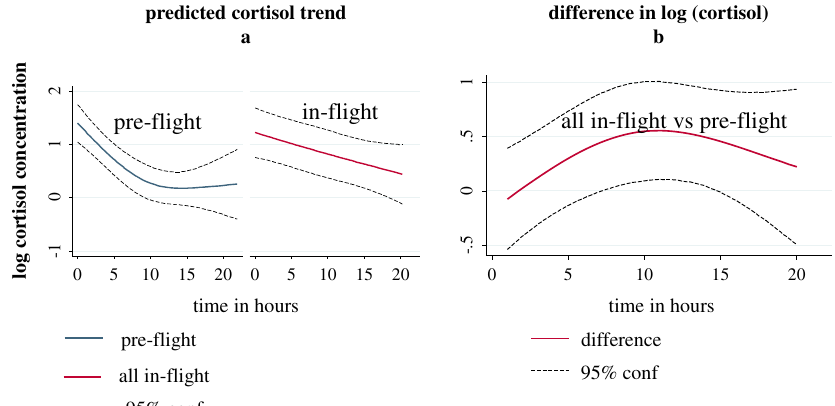
Fig. 5 Predicted mean log cortisol concentration trend and 95% con fi dence intervals for before- fl ight and during- fl ight phases in ( a ). b shows the difference between the two phases as well as the 95% con fi dence interval. It can be seen that the greatest difference occurs at about 10 h after waking based on these estimations